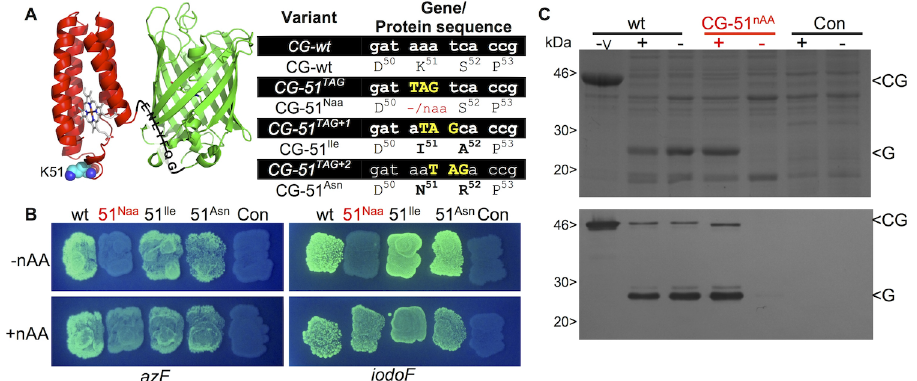
Fig 2. Selection for in-frame TAG replacement. (A) Schematic of the cytochrome (red) and sfGFP (green) fusion with the TEV cleavage site between the two shown. The residue targeted (K51) for replacement and the rational TAG replacements are shown. (B) cellular fluorescence of each variant in the absence (-nAA) and presence (+nAA) of either azF or iodoF. The wt refers to the cyt b 562 -sfGFP fusion without any TAG codon replacement. (C) SDS-PAGE (top panel) and Western blot (bottom panel) analysis of fusion protein expression in the soluble fraction of the cell lysate. The — v lane represents cells producing CG-wt in the absence of the pAB vector. The + and — lanes refer to the presence or absence of the nAA, respectively. CG and G refer to the cyt b 562 -sfGFP fusion (~40 kDa) and the sfGFP alone (27 kDa) generated through TEV cleavage. The Western blot detection was performed with an antiGFP primary